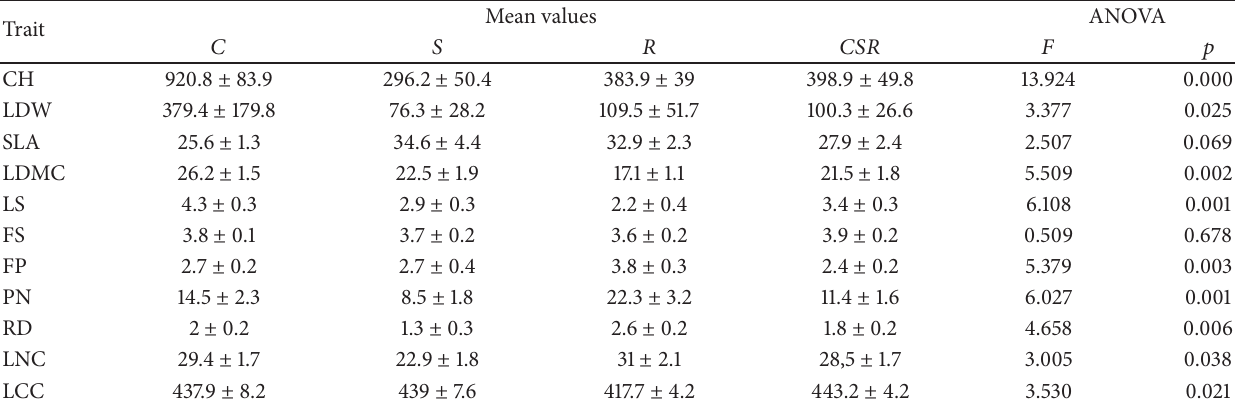
Table 2: Morphological and physiological traits of plant species of different functional